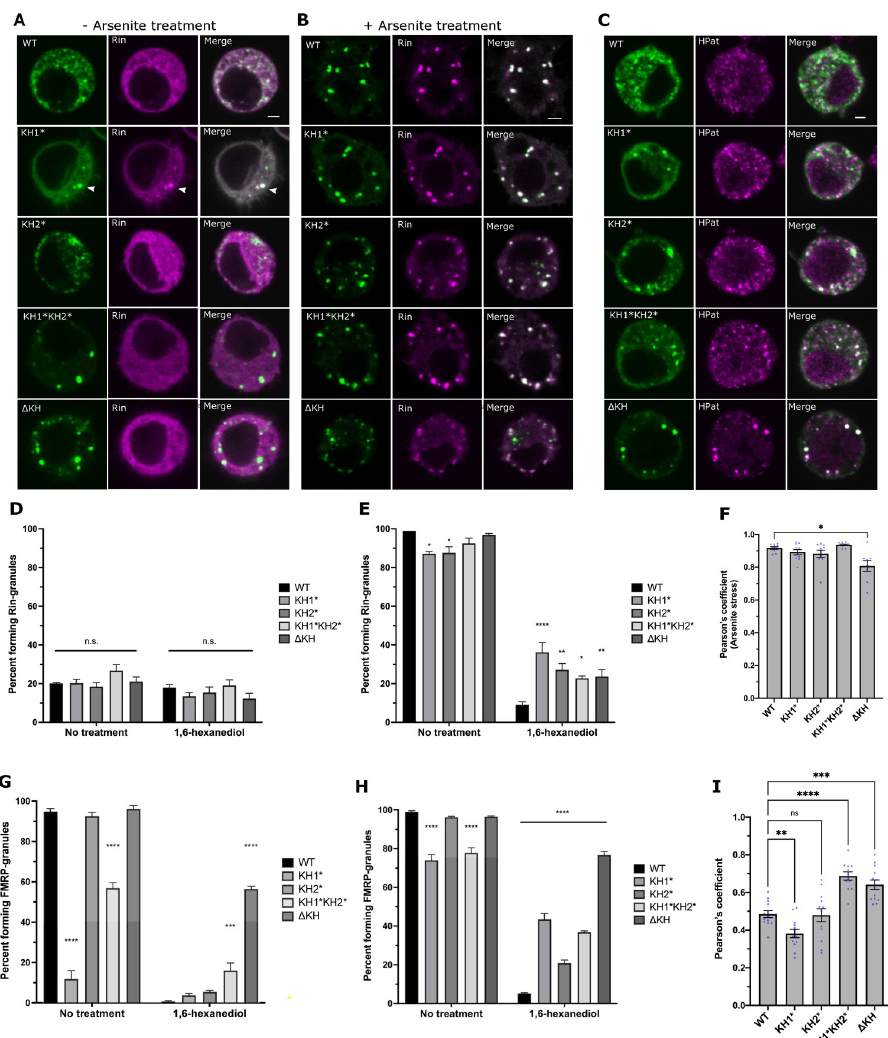
Fig 4. FXS-causing mutations alter SG dynamics and PB association. Representative images of S2R+ cells transfected with GFP-FMRP mutants (green) and Rin-mCherry (magenta) that are either not treated (A) or treated (B) with 0.5mM sodium arsenite for 45 minutes. Scale bars = 2 μ m. (C) Representative images of the localization of transiently transfected GFP-FMRP mutants immunostained against GFP (green) and HPat (magenta). Scale bar = 2 μ m. Percent of unstressed (D) or arsenite stressed (E) transfected cells forming Rin-positive SGs with or without 10% 1,6-HD treatment. Comparisons are made to WT-FMRP in each subcategory (mean ± SE; ~100 cells in triplicate; one-way ANOVA). (F) Average Pearson’s correlation coefficient between FMRP-mutants and the stress granule marker, Rin, in arsenite treated cells (mean ± SE of 8–10 cells; Brown-Forsyth test). Percentage of unstressed (G) or arsenite stressed (H) transfected cells forming FMRP granules with or without 10% 1,6-HD compared to WT-FMRP (mean ± SE; ~100 cells in triplicate; one-way ANOVA). (I) Average Pearson’s correlation coefficient between FMRP-mutants and HPat (mean ± SE of 12–13 cells; one-way ANOVA). In all graphs: � p < 0.05, �� p < 0.01, ��� p < 0.001, ���� p < 0.0001.